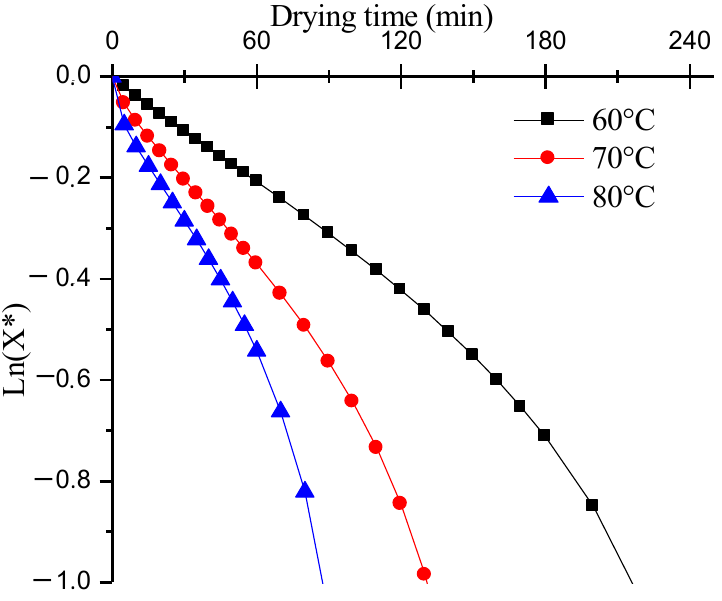
Figure 7. Effects of both air flow and temperature on the effective diffusion coefficient. Table 4. Values of the effective diffusivity and activation energy of the Arbutus unedo The activation energy is defined as the amount of energy needed to remove moisture of a solid sample. Higher value of the activation energy means higher temperature sensi ‐ bility of the Deff coefficient [62]. The average activation energy recorded for Arbutus un ‐ edo L. is 2203.46 kJ/kg with an R 2 of 0.9486 (Figure 8). Similar results were reported for white mulberry [69], and for black mulberry fruits [57].